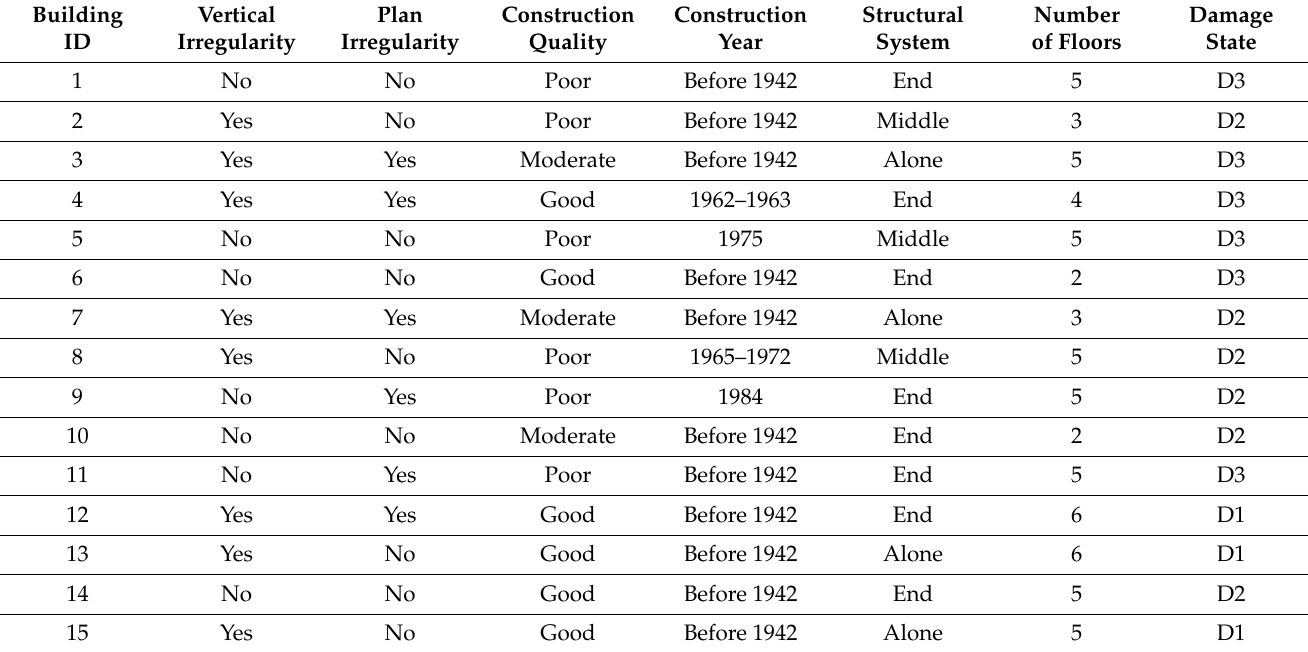
Table 5. 2019 Albania post-earthquake building screening data to validate the S-RVS